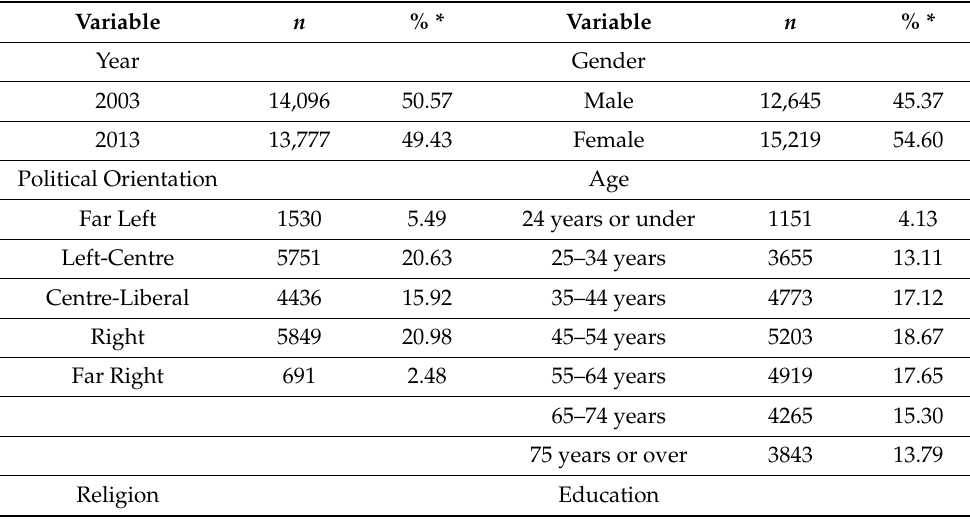
Table 1. Survey socio-demographic characteristics ( n and